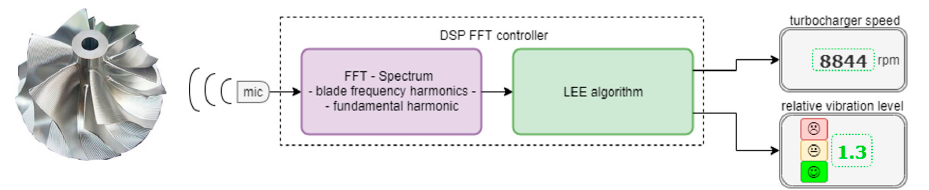
Figure 9. Block diagram of the acoustic-based turbocharger continuous monitoring system.